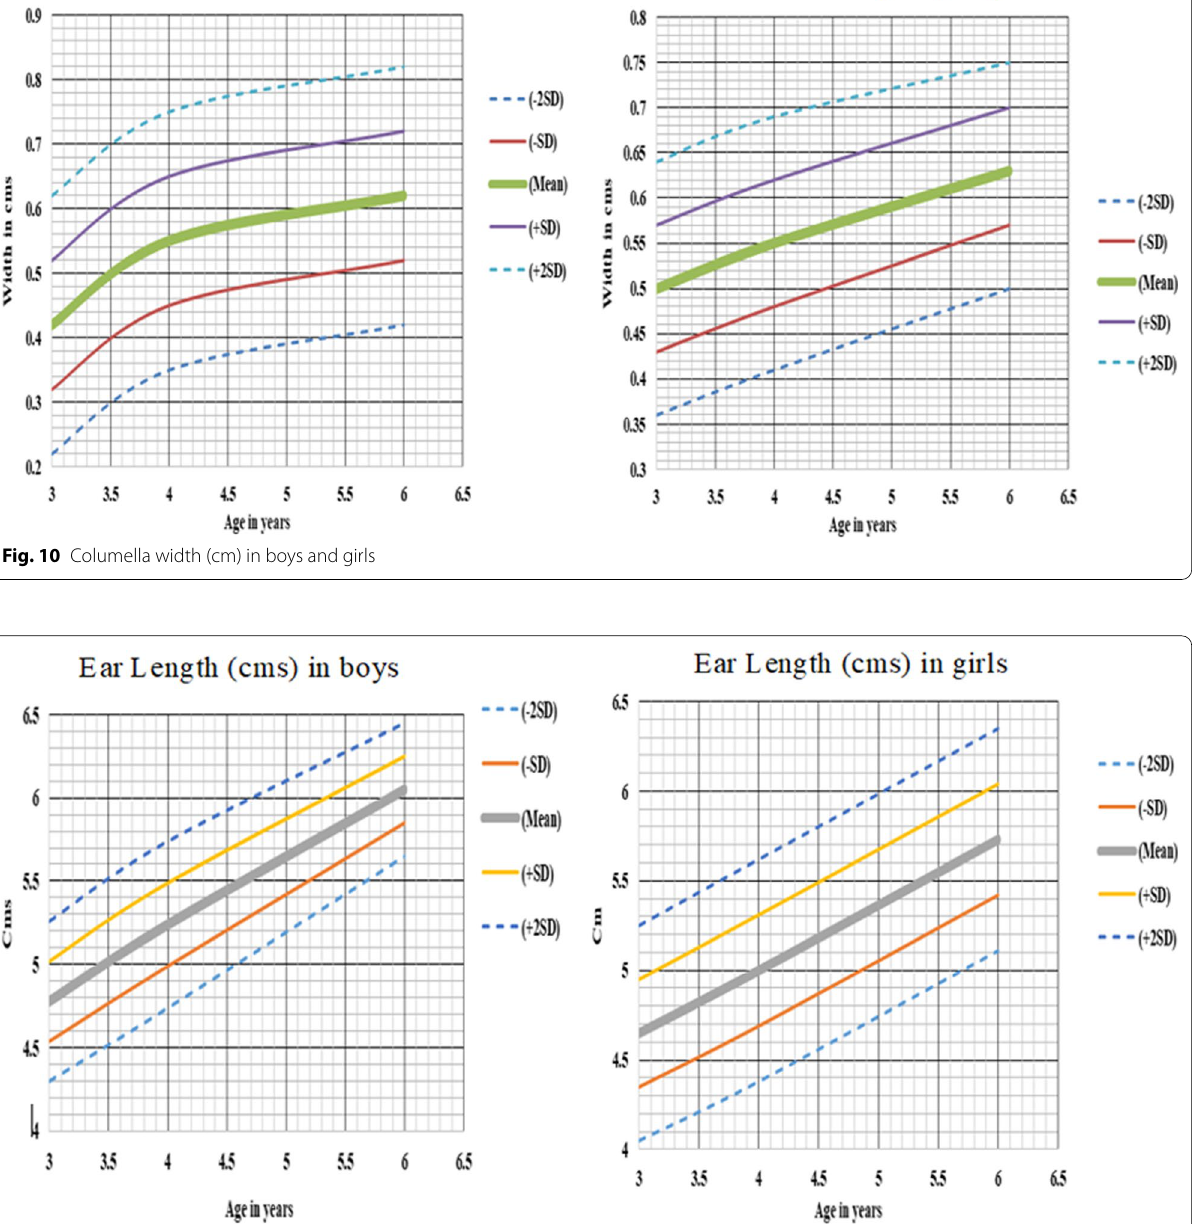
and from 4.8 to 5.3 cm, respectively, with no significant difference between both sexes [5]. Another similar find- ing was evident in a study on Iranian children which reported mean values of inner canthal distance (ICD) ranged from 2.91 to 2.92 cm with a p -value of 0.9, outer canthal distance (OCD) ranged from 7.5 to 7.7 cm with a p -value of 0.01 and inter-pupillary distance (IPD)